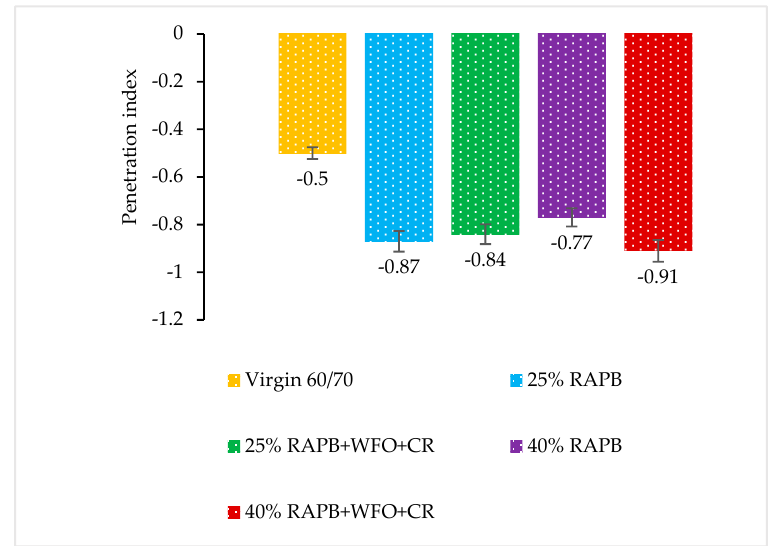
Figure 4. PI outcome for all binders.